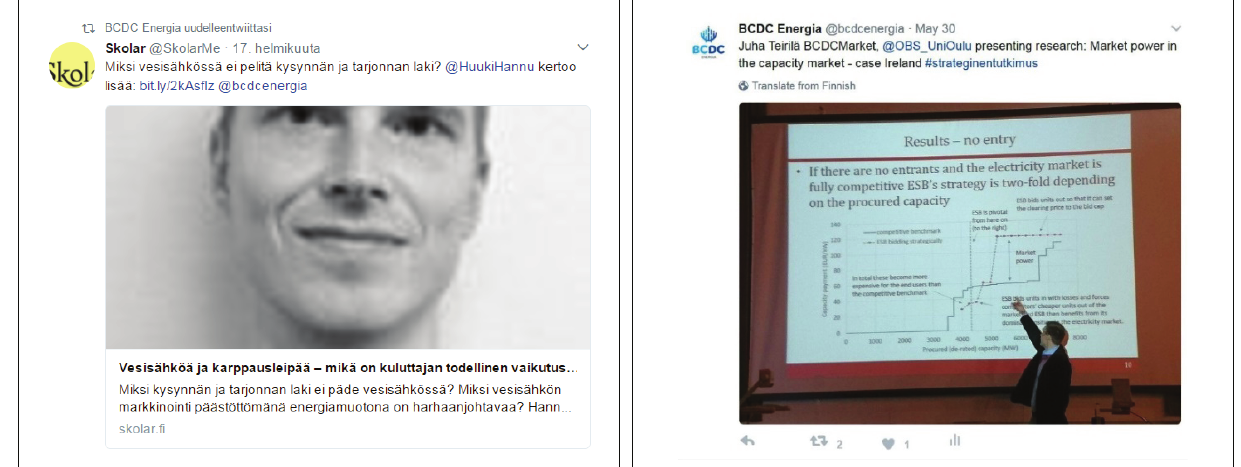
Figure 1. Examples of portraits in tweets. Source: BCDC Energy (2017a, 2017b). general standpoints that are not well justified with